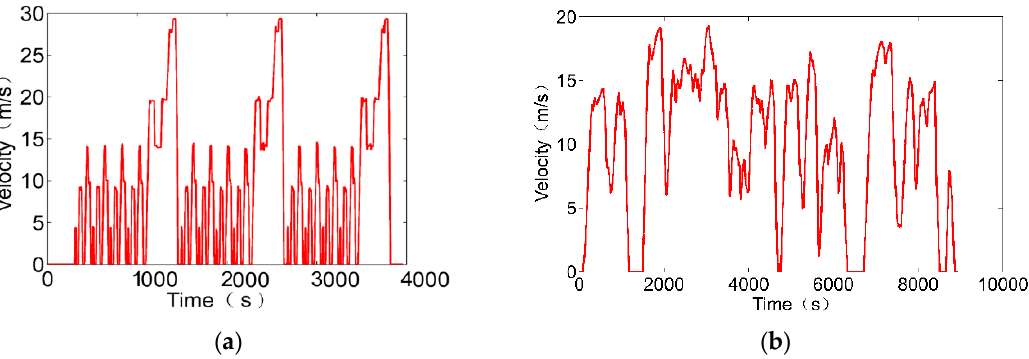
Figure 2. Two driving cycles to verify the accuracy of the EV model: ( a ) the 3 new energy driving cycles (NEDCs) on the test bench; ( b ) the actual road driving cycle.